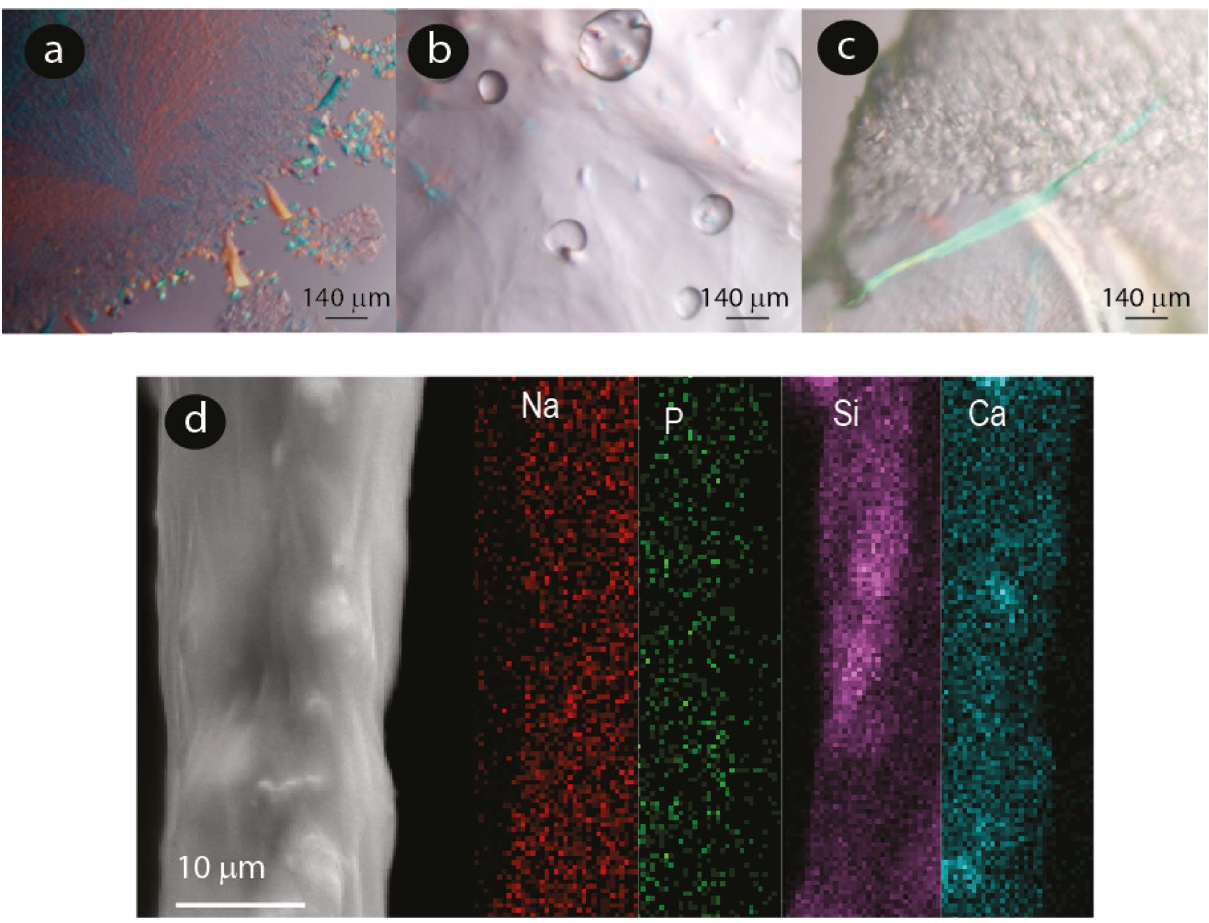
mechanical stimulus. ( d ) SEM micrograph of an expelled slime fiber and elemental mapping using